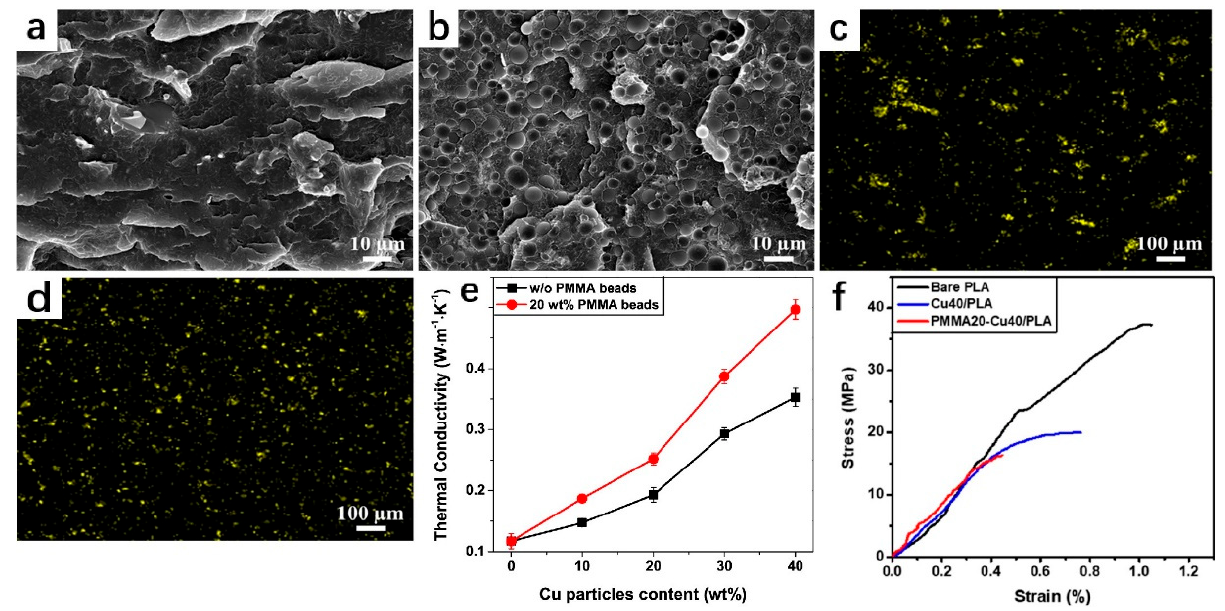
Figure 11. ( a , b ) SEM image of Cu40/PLA composite and Cu40/PLA/PMMA; ( c , d ) EDS mapping of Cu40/PLA composite and Cu40/PLA/PMMA; ( e ) thermal conductivity with different copper content in PLA/PMMA/Cu and PLA/Cu composites; ( f ) tensile curves of printed pure PLA and PLA composites (reproduced with permission from Reference [82], Copyright 2020 Elsevier).